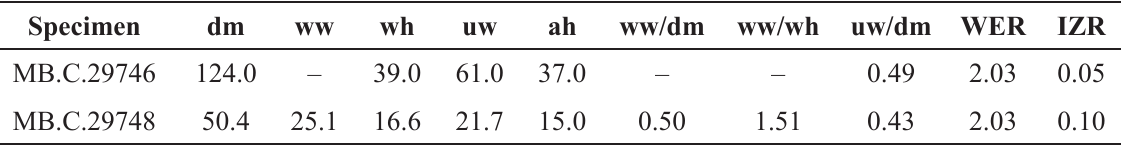
Table 8. Conch dimensions (partly estimated) and ratios of selected specimens of Dzhulfites brevisellatus Korn & Hairapetian sp. nov. from Baghuk